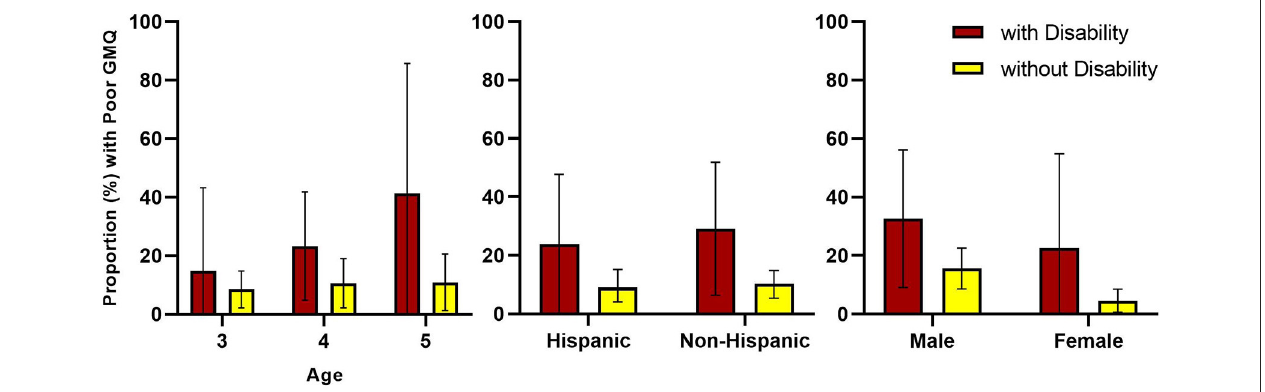
FIGURE 2 | Proportion of poor motor competency between children with and without disabilities by age, Hispanic origin, and sex. GMQ, gross motor quotient.